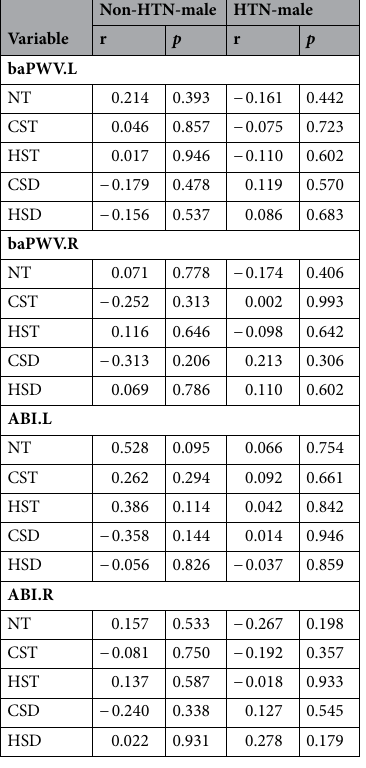
Table 4. Correlation analysis between male microvessel area and arterial